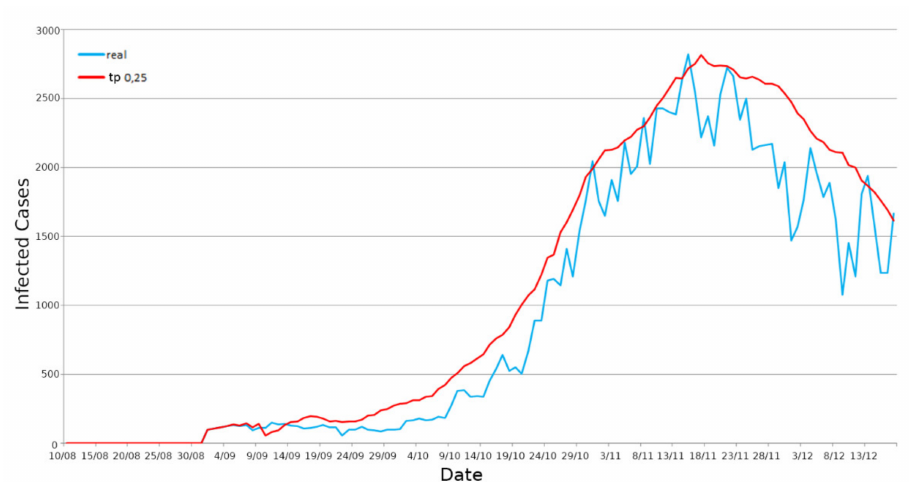
Figure 12. Positives’ daily representation—Emilia Romagna region.